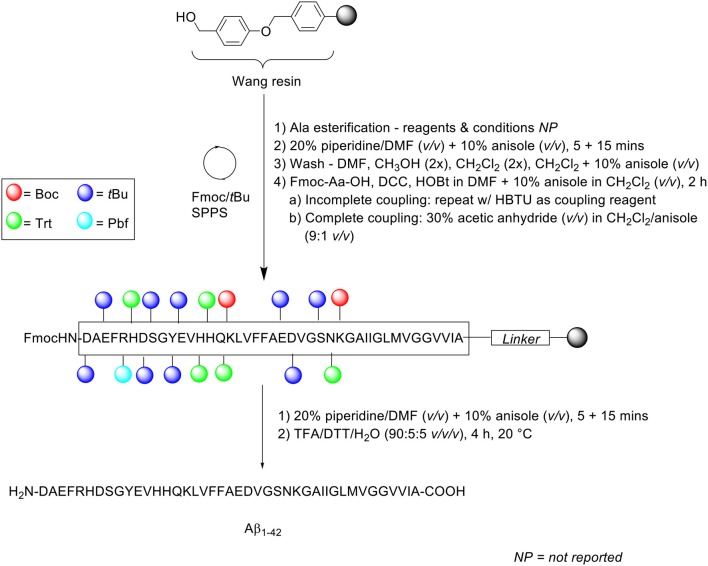
Fmoc/tBu SPPS of Aβ1−42 using anisole as co-solvent by Zarándi et al. (2007).